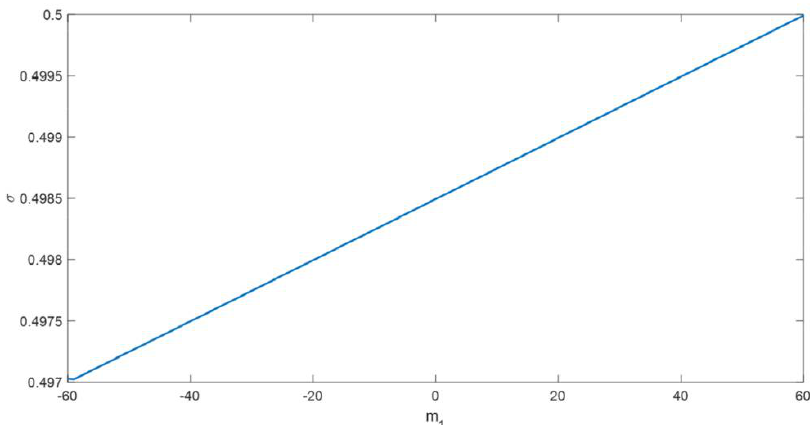
Figure 10. The effect of learning function value on the σ.